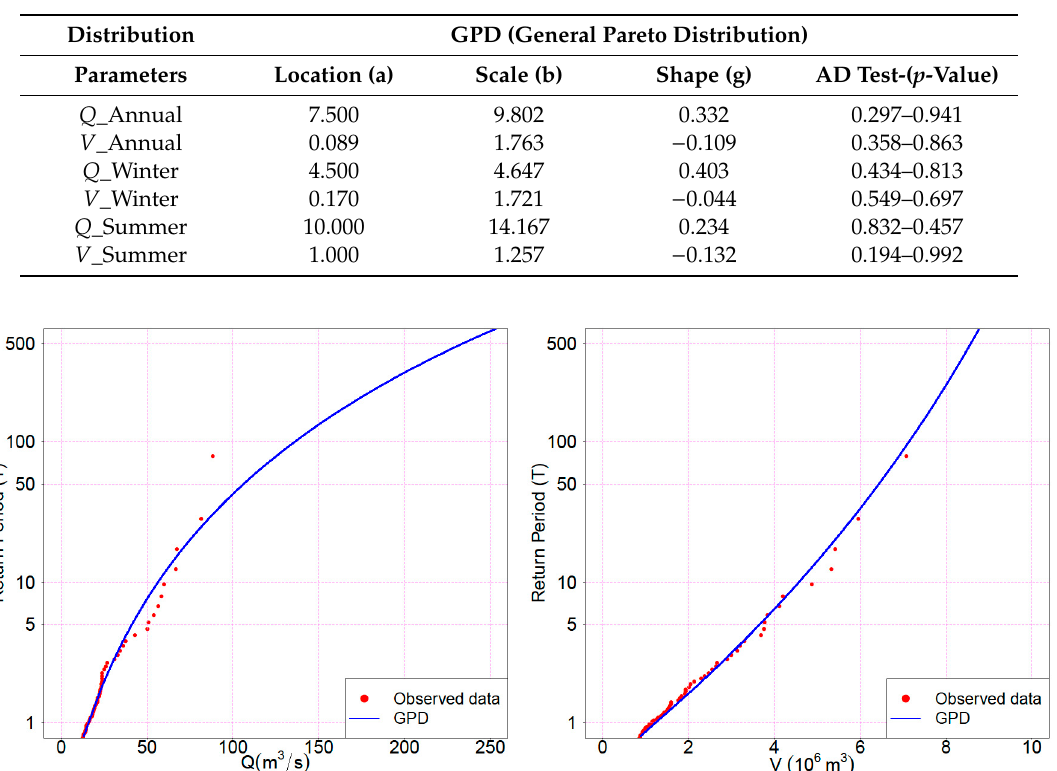
Figure 7. Empirical CDFs and GPD with PWM parameter estimation.